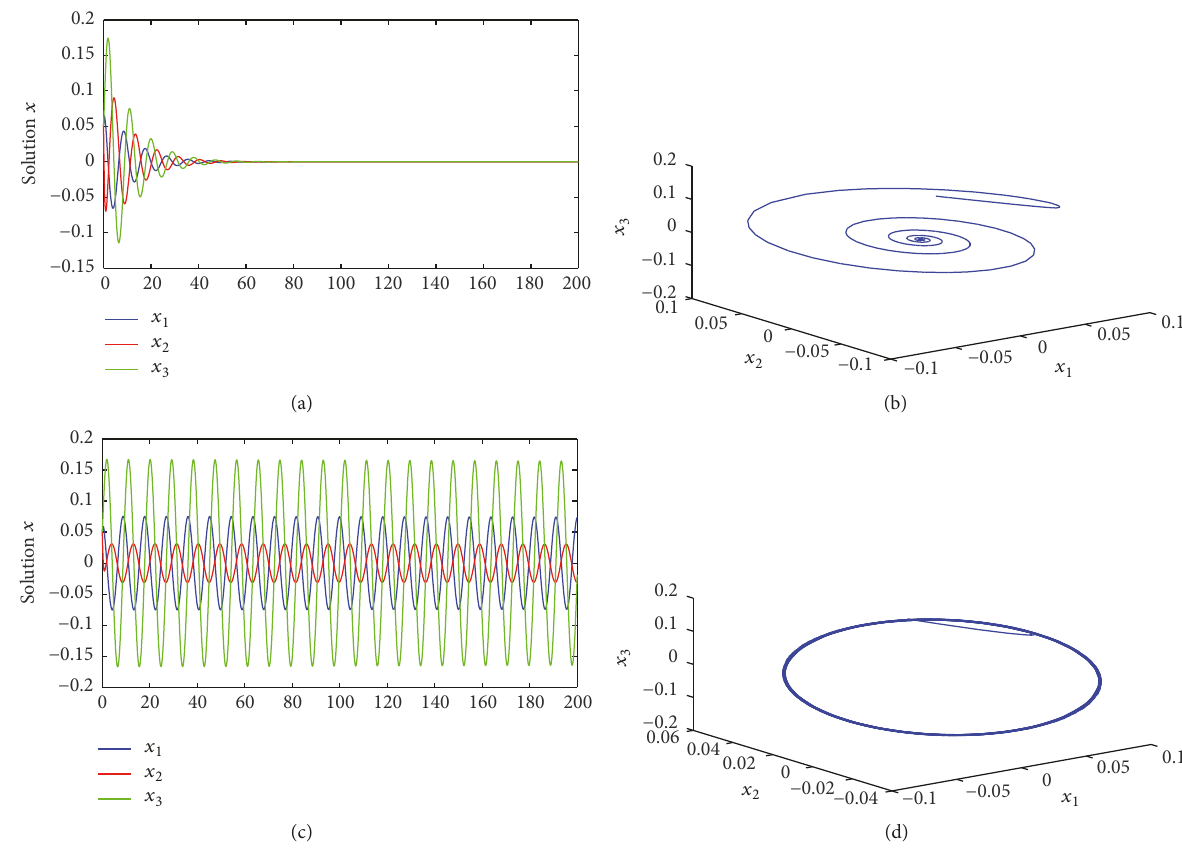
Figure 6: The corresponding oscillation curves and phase portrait of the PI hydroturbine governing system. (a) The corresponding oscillation curves with 𝐾 𝑃 = 5 and 𝜏 2 ∈ [0, 𝜏 20 ) . (b) The phase portrait with 𝐾 𝑃 = 5 and 𝜏 2 ∈ [0, 𝜏 20 ) . (c) The corresponding oscillation curves with 𝐾 = 1.2, 𝜏 = 0.01 s, and 𝜏 ≥ 𝜏 𝑃 1 2 2∗ . (d) Hopf bifurcation occurs for